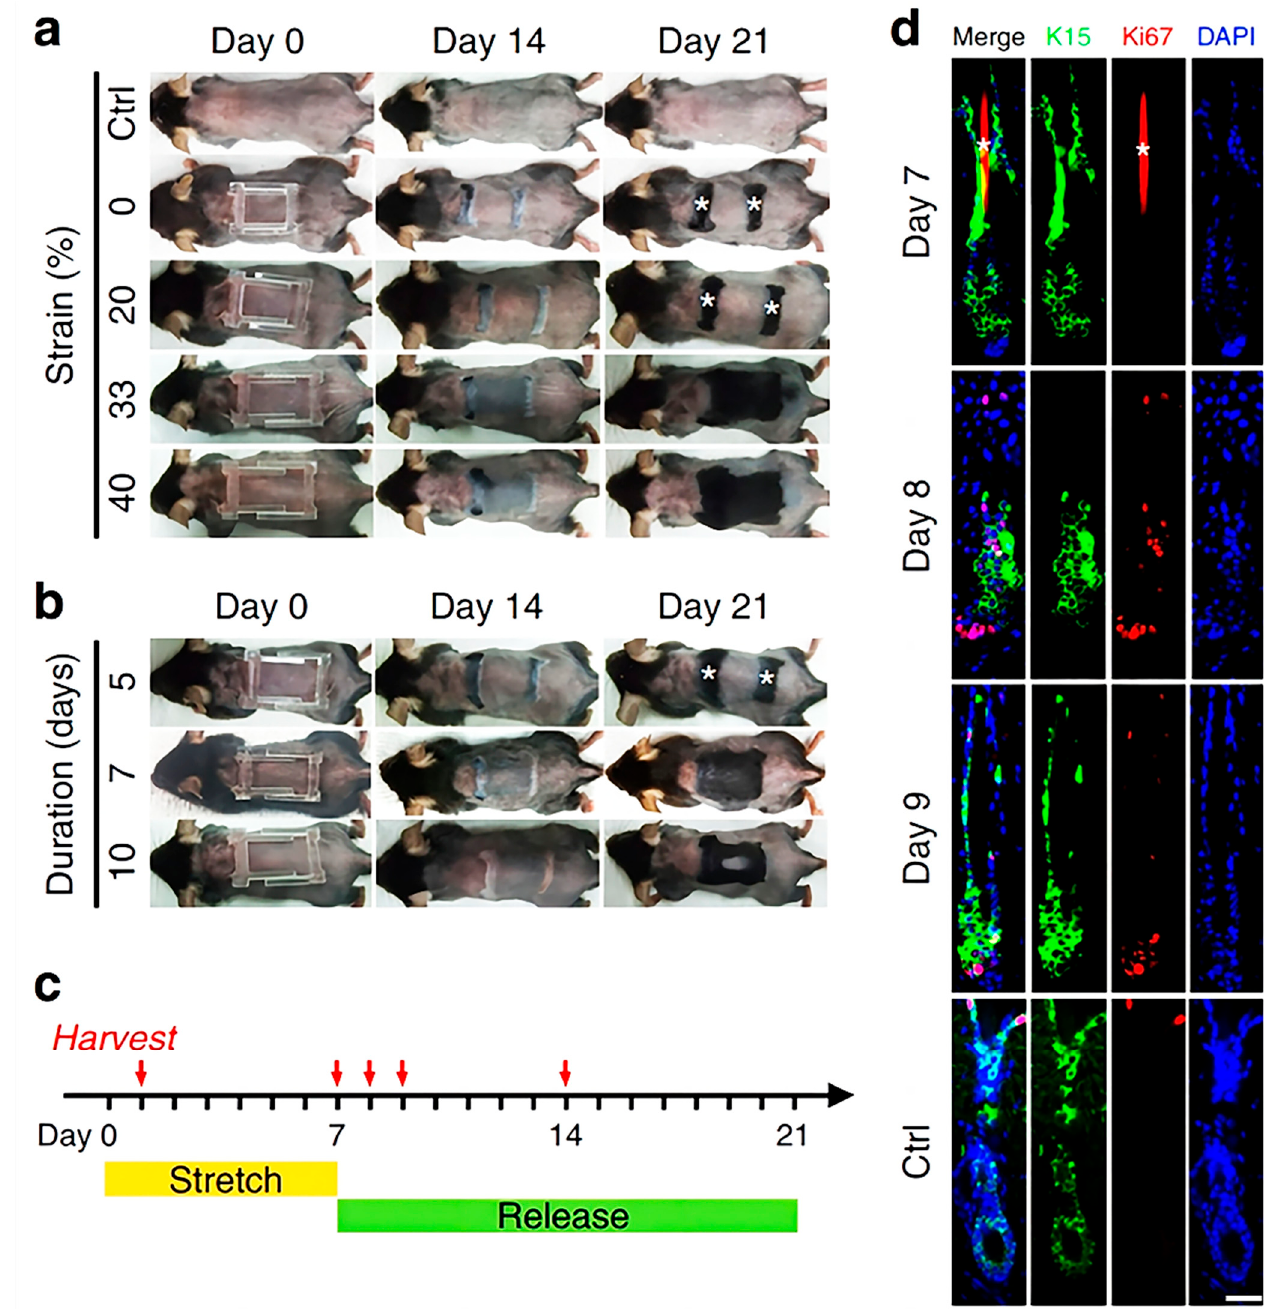
Figure 5. Stretch-induced hair regeneration is dependent on strain and duration. ( a ) Stretch for 7 days under di ff erent amounts of strain. * Anagen initiated in glue- fi xed area due to hair plucking when removing the skin-stretching device. ( b ) Stretch under 33% strain for di ff erent durations. ( c ) Schematic showing the optimal stretching conditions and sample collection times. Red arrows mean the time of harvest mice. ( d ) Dual immunostaining for K15 and Ki67 revealed that K15 + hair stem cells began to proliferate on days 8 and 9 when stretch was released. *Auto fl uorescence of hair shafts. Scale bar = 50 µm [32]. Copyright 2019 Nature.